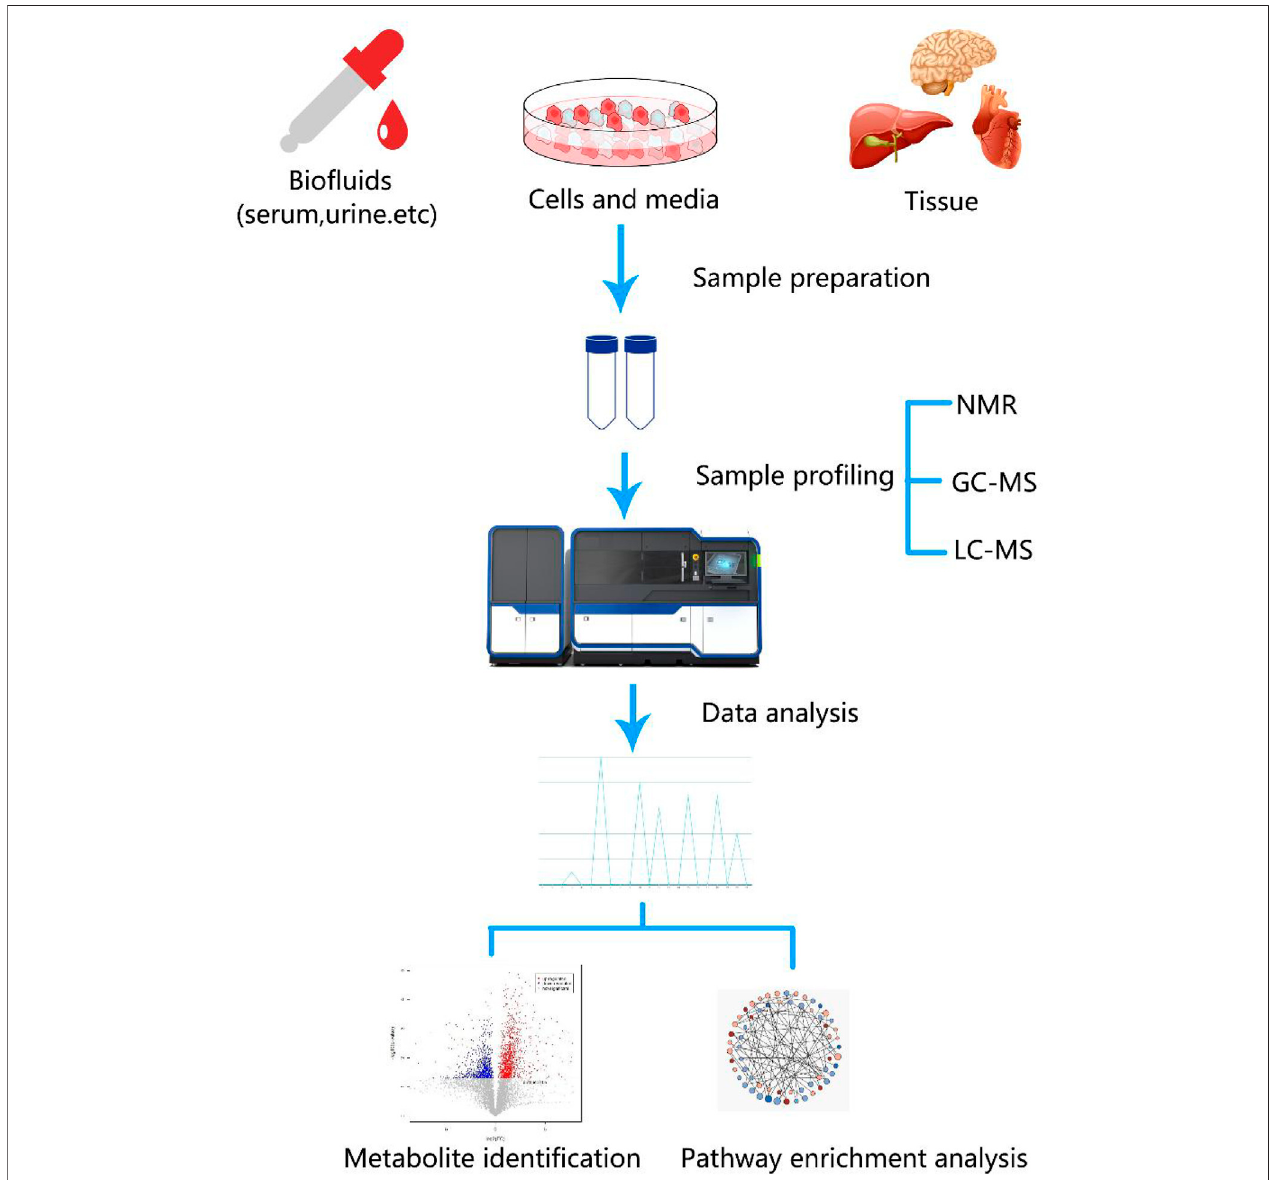
FIGURE1|(A) Analyticalwork fl owofmetabolomicsstudies. Atypical metabolomics studyincludesexperimental design, sample collection, samplepro fi ling, data analysis, and functional interpretation stages. Metabolites from biological fl uids, cells, and tissues that differ between tumor and control groups can be detected using metabolomics [e.g., nuclear magnetic resonance (NMR), liquid chromatography-mass spectrometry (LC-MS), and gas chromatography-mass spectrometry (GC-MS)] and data analyses. Discovery of metabolic biomarkers and pathways that are speci fi c to certain cancers bene fi t cancer